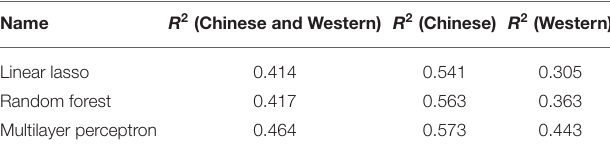
TABLE 5 | Comparison of accuracy of fusion models.